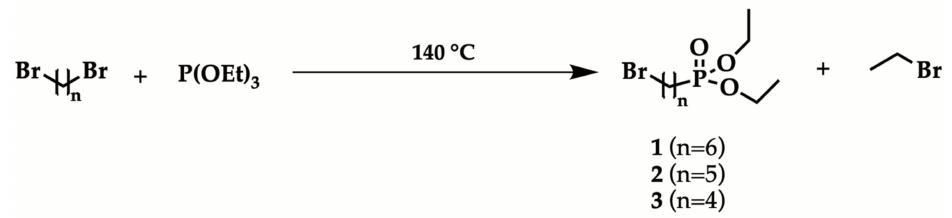
Scheme 2. Diethyl ω -bromoalkylphosphonates synthesis. Table 1. Optimization of reaction conditions for the synthesis of diethyl ω